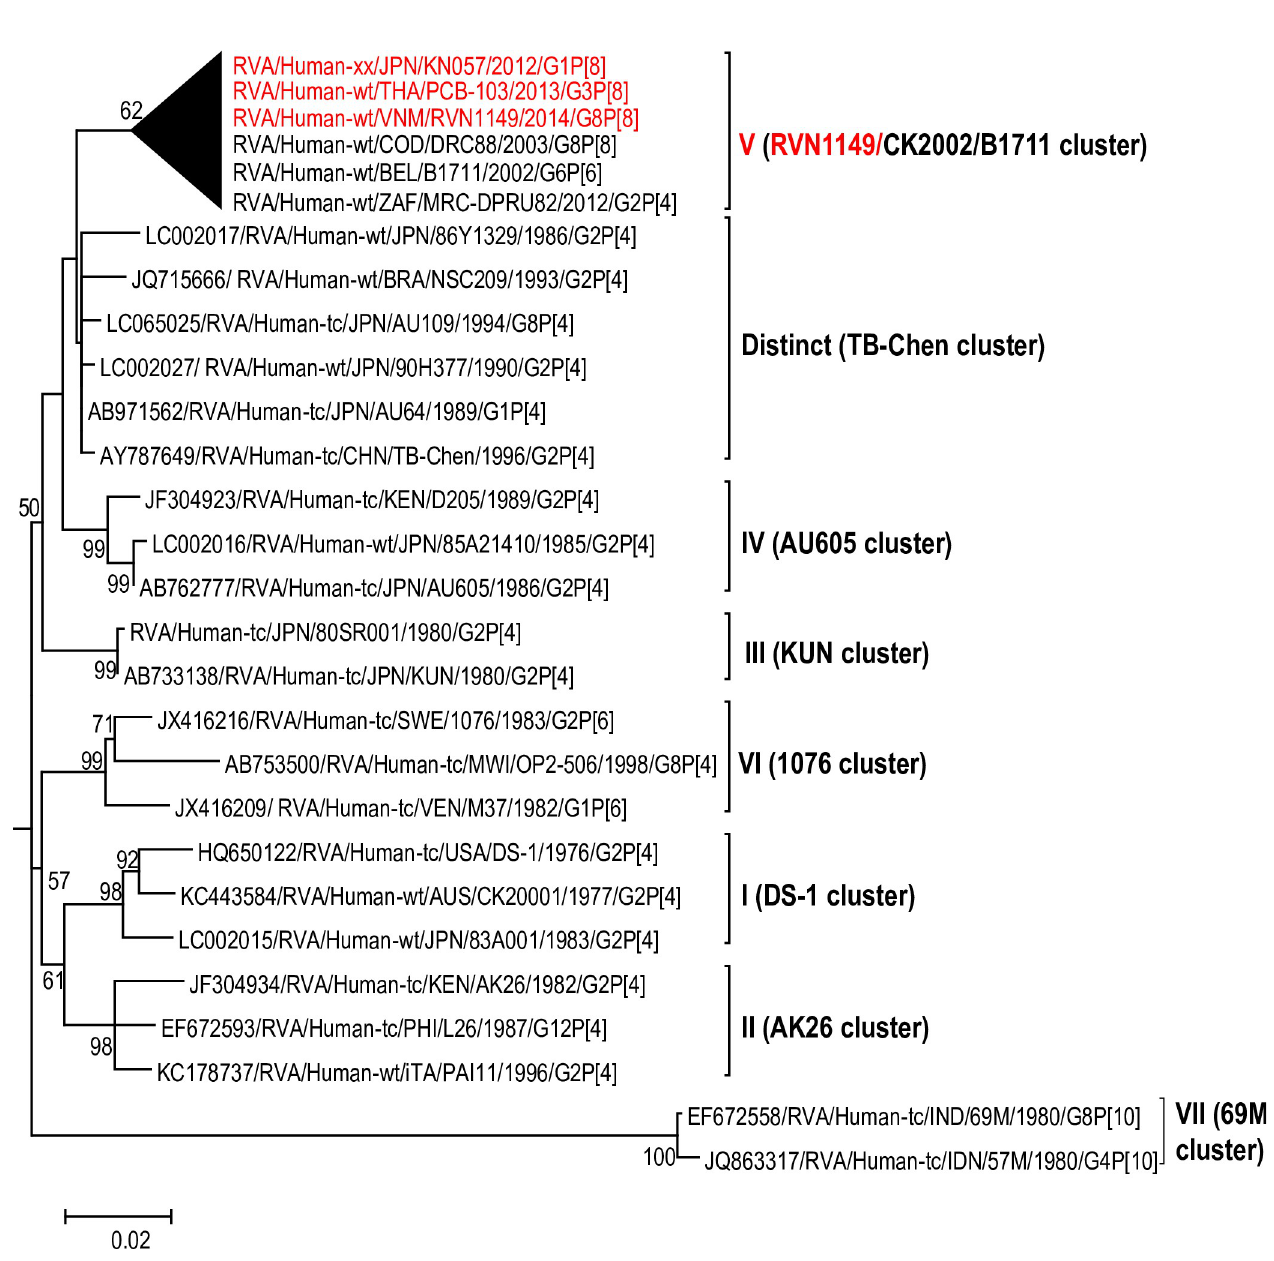
Fig 9. Reference phylogenetic lineage designation for the NSP3-T2 genotype of RVA strains. Phylogenetic tree was constructed using the maximum likelihood method with 1000 bootstrap replicate trials. The tree was rooted using the NSP3-T1 gene of the genotype 1 prototype strain Wa. Representative unusual emerging reassortant strains whose lineage constellations were determined in this study using the newly established phylogenetic framework are indicated in red font. Scale bar at the bottom of the tree represents genetic distance expressed as nucleotide substitutions/site.